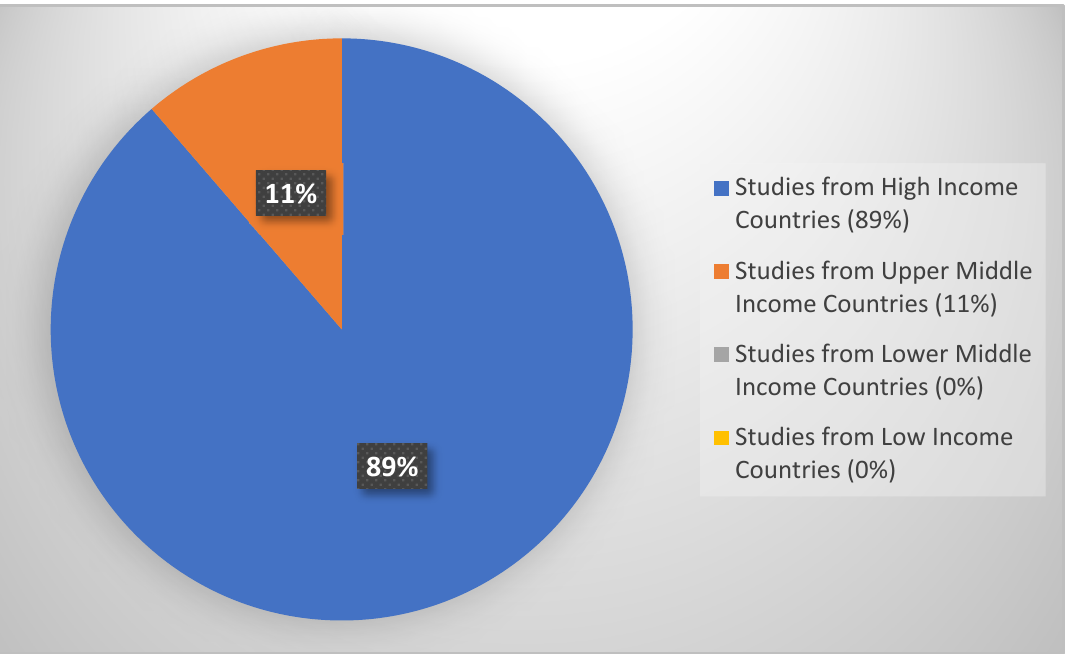
Figure A1. Original Research Studies on Air Pollution and Cognition as per World Bank Classification of the Income Level of the Country.